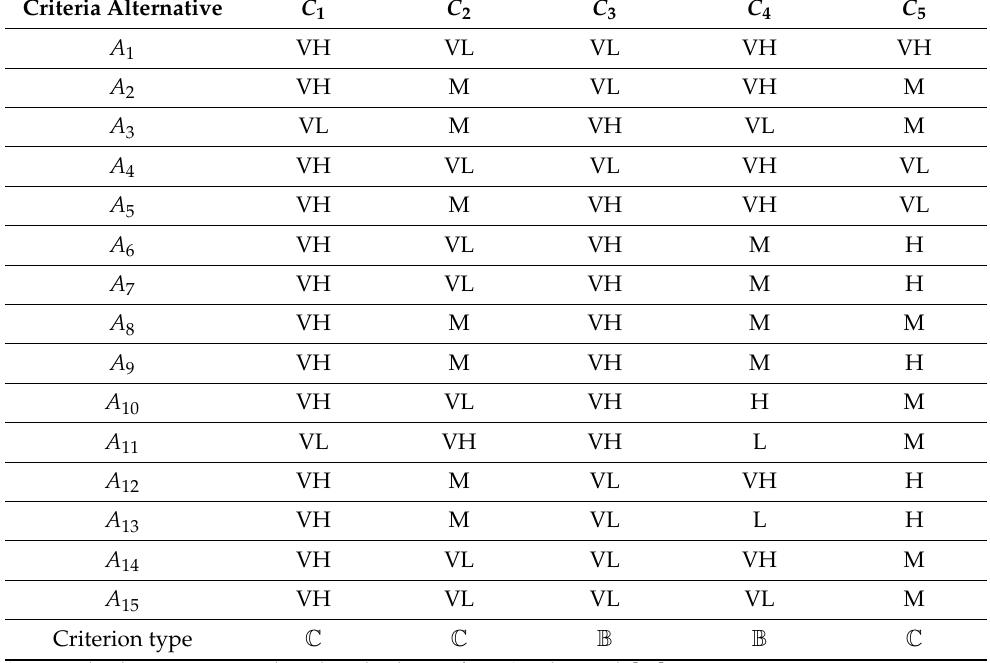
Table 2. Input decision matrix for COVIF-19 vaccine selection.